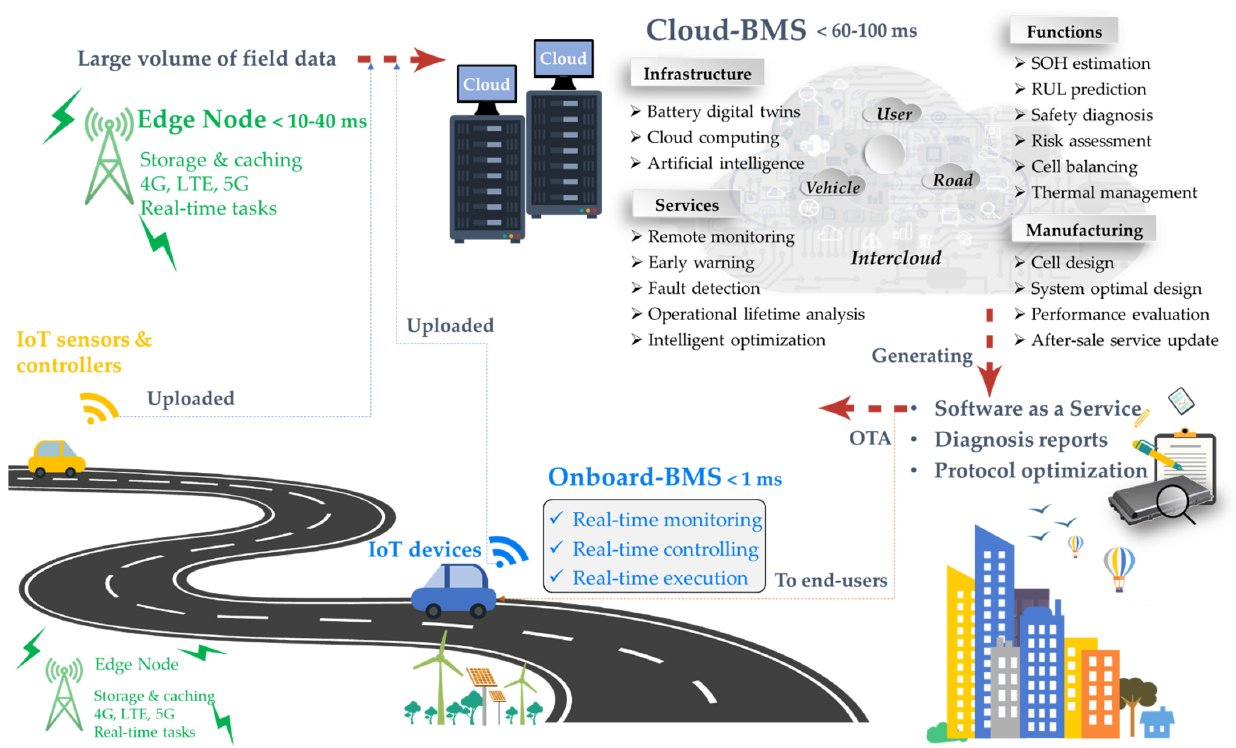
Figure 7. Cloud-based solution for the diagnosis and prognosis of battery lifetime and safety.